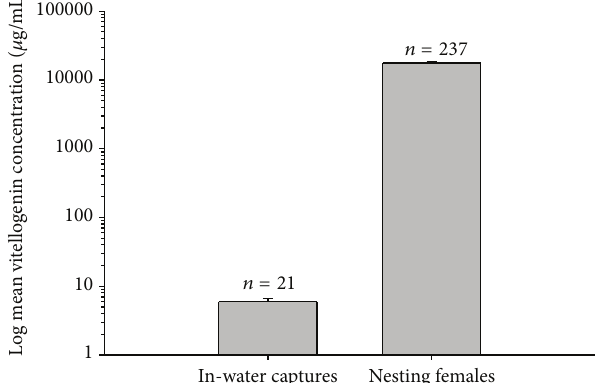
Figure 3: Overall mean plasma vitellogenin concentration mea- sured in turtles from in-water captures in 2008 and 2009, and in nesting females sampled in 2008. Error bars represent the standard error of the mean. The mean vitellogenin concentration measured in nesting females was significantly higher than the mean vitellogenin concentration measured in samples from in-water captures ( 𝑃 < 0.001